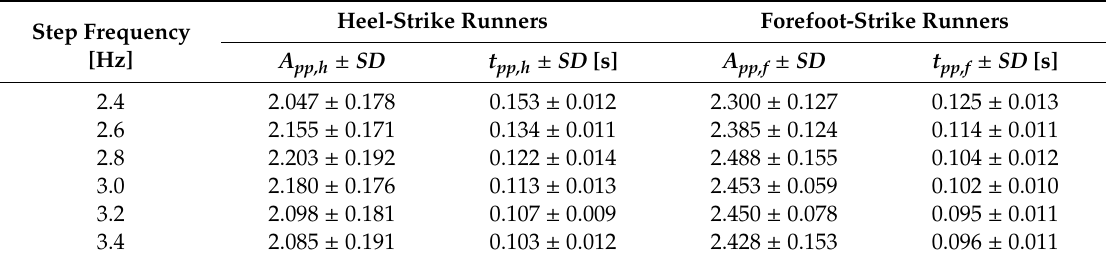
Table 1. A pp,h , A pp,f , t pp,h , t pp,f indicators of the F VGRF curve (mean ± standard deviation).